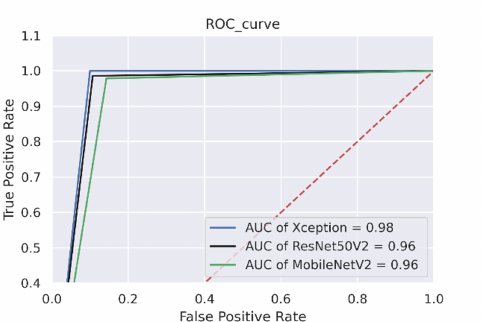
Figure 10. ROC curves for all models using the dataset introduced by Ref. [28].